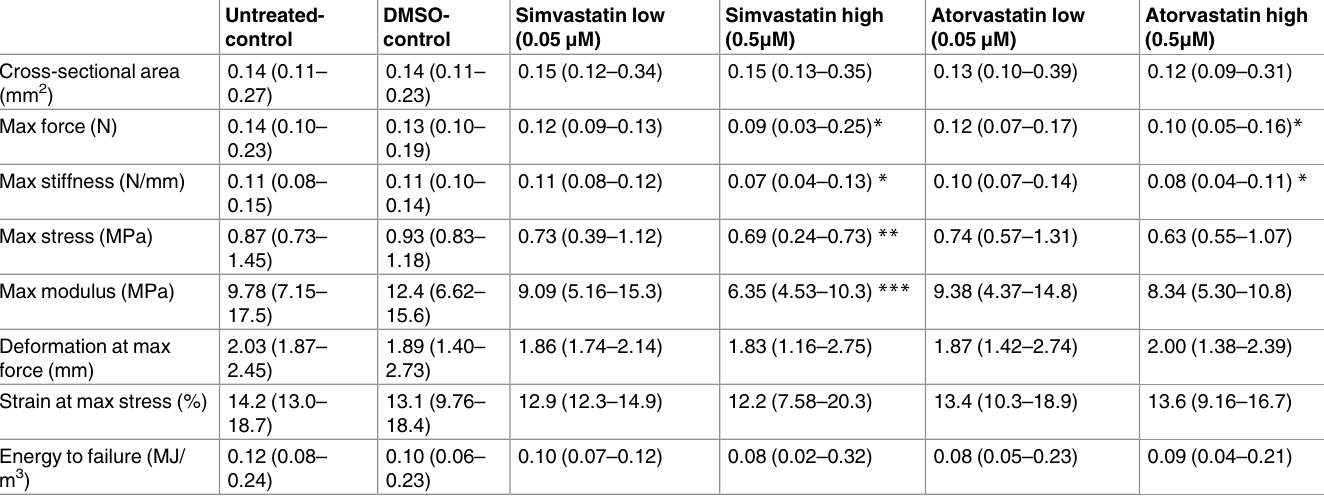
Table 2. Mechanical